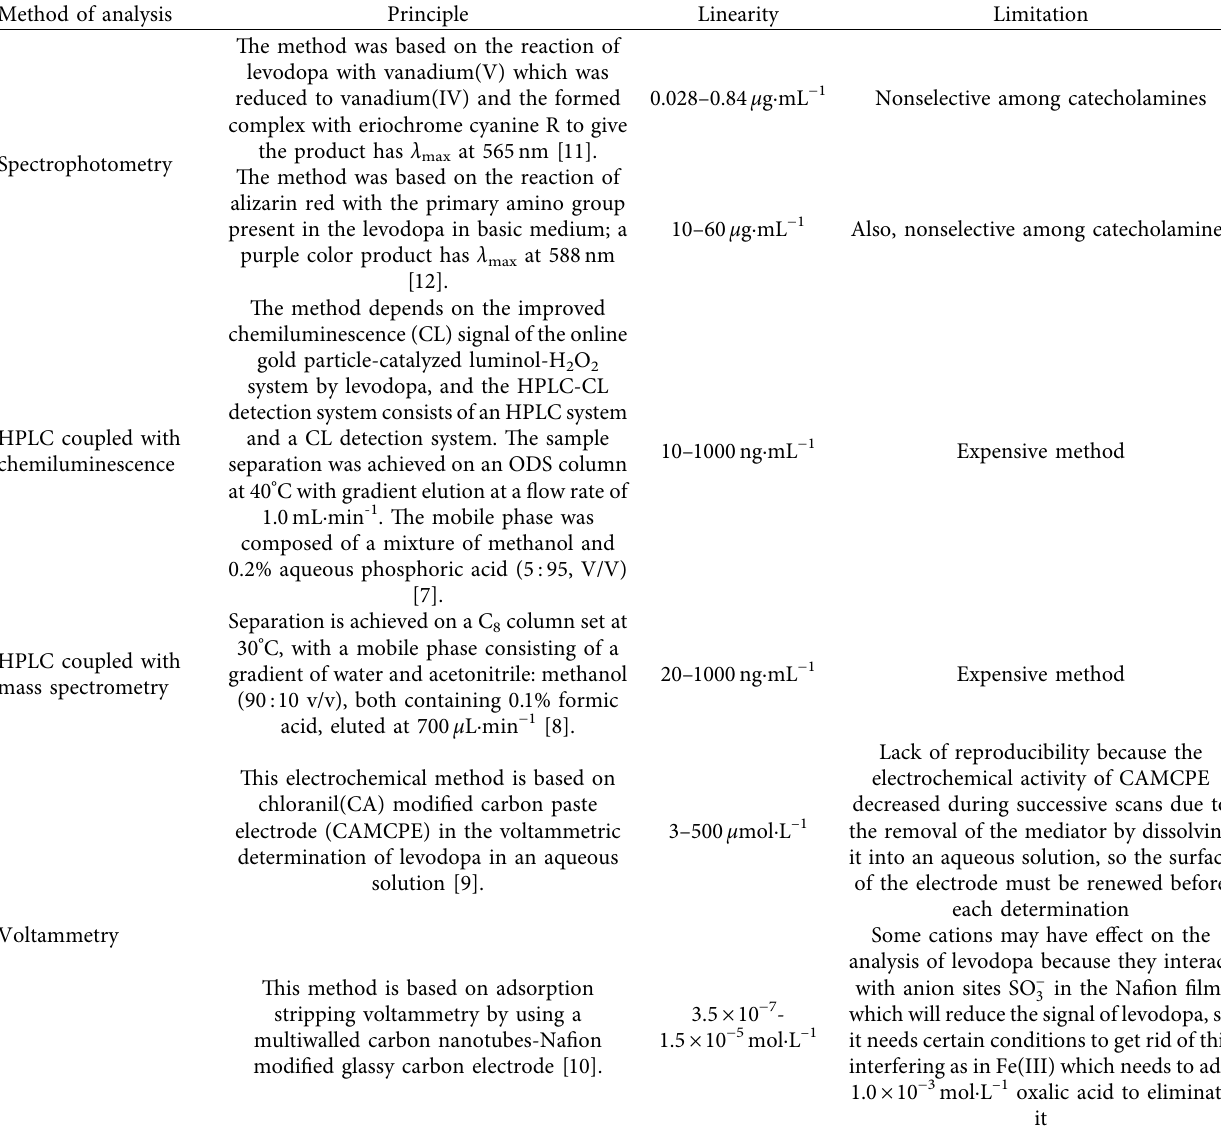
Table 1: Comparative analytical results of the proposed approach with various previously described methods for determining levodopa. Method of